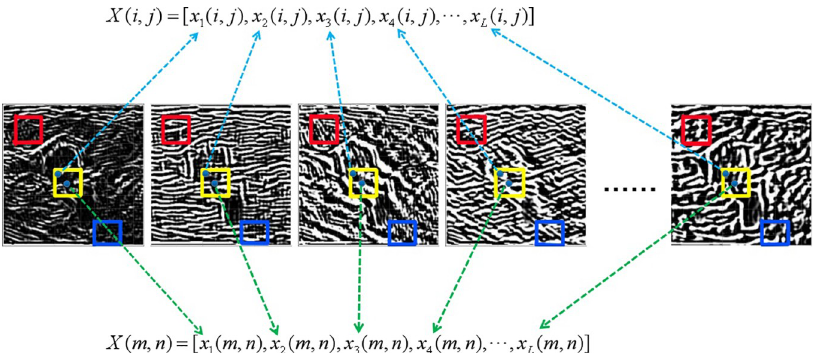
Fig 2. A detailed illustration of the construction of feature vectors based on the feature